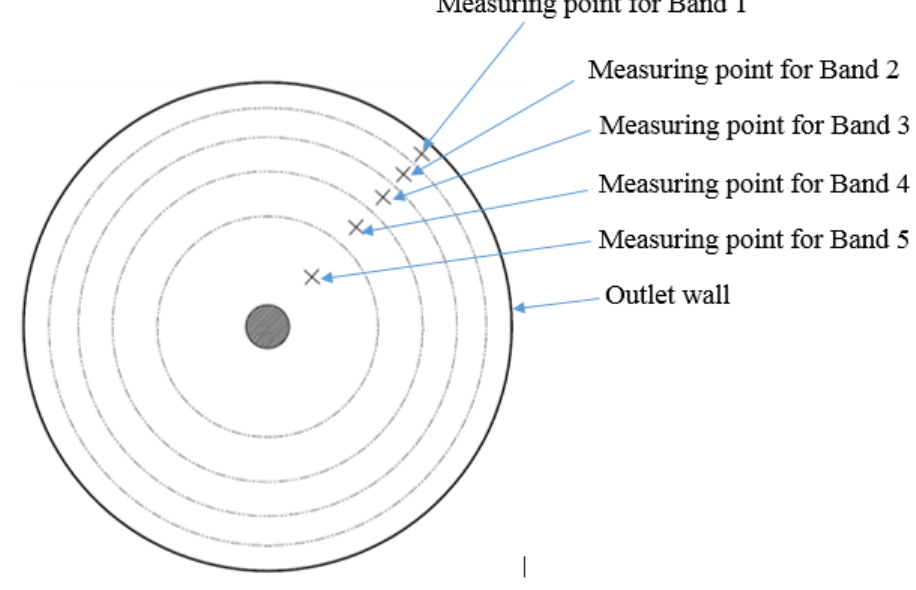
Figure 3. Measuring points for each band at the discharge